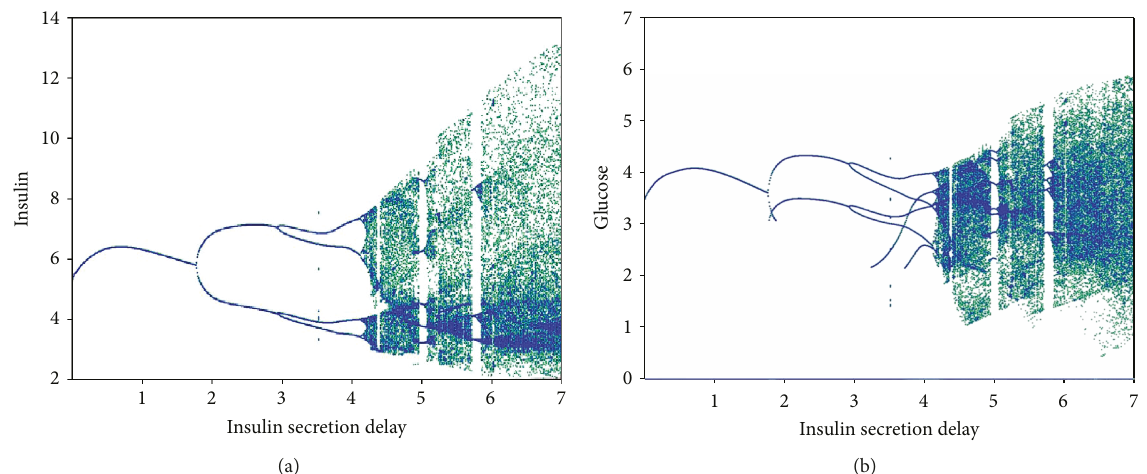
Figure 2: The model bifurcation diagrams based on di ff erent values of parameter τ